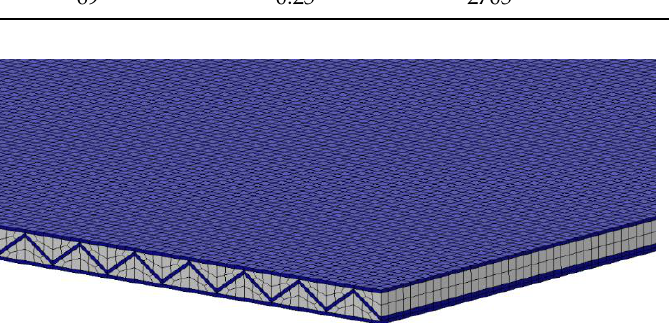
Figure 3. Detailed 3D finite element model of the HCS plate in MSC.Nastran simulation.